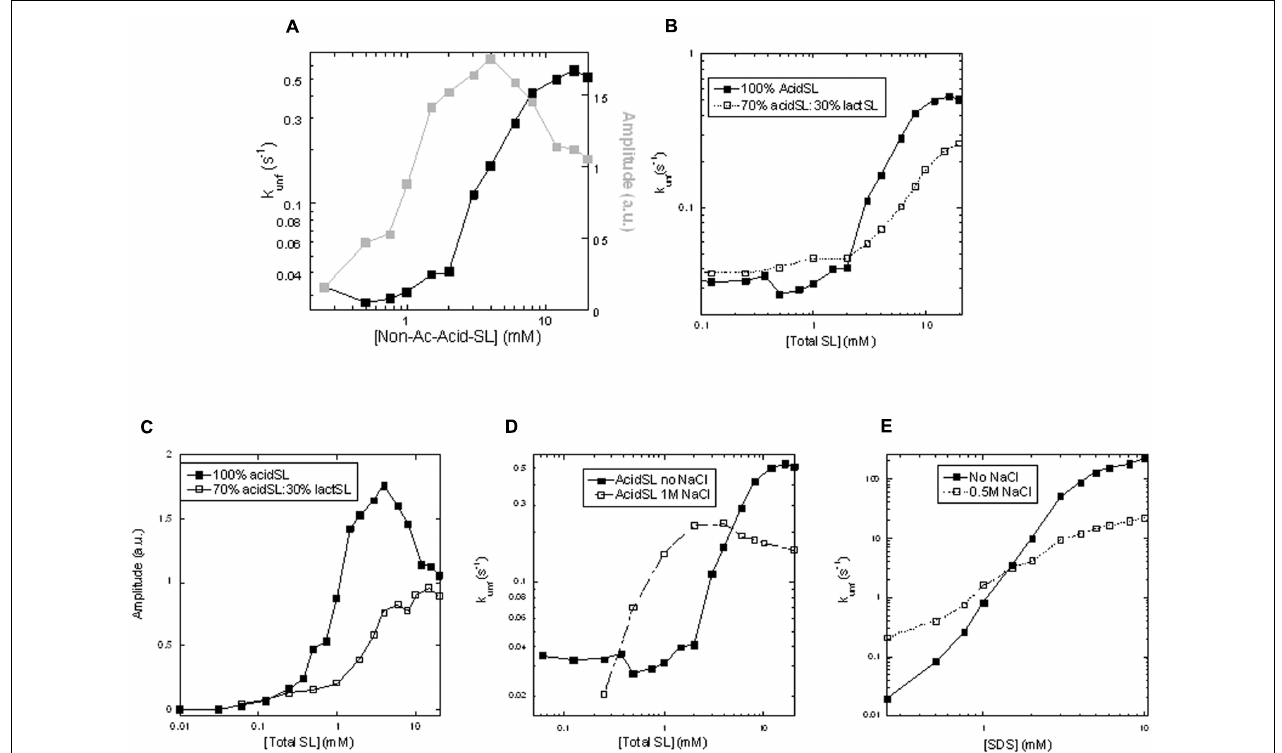
FIGURE 4 | Kinetics of unfolding of apo-aLA in SL. (A) Amplitudes and rate constants in pure acidSL. (B) Rate constants and (C) amplitudes of unfolding in pure acidSL and mixtures of 70% acidSL and 30% lactSL. (D) Rate constants of unfolding of apo-aLA in acidSL in 0 and 1 M NaCl. (E) Rate constants of unfolding of apo-aLA in sodium dodecyl sulfate (SDS) in 0 and 1 M